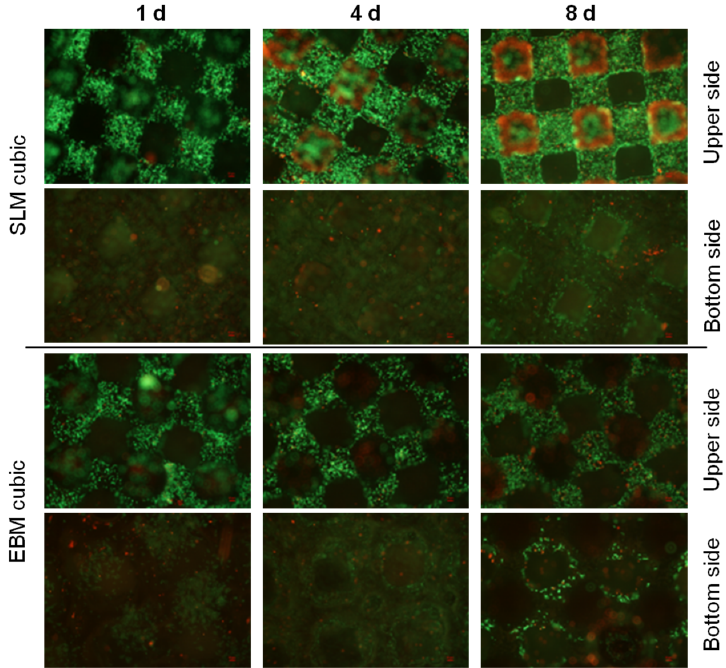
Figure 6. Live/dead staining of cubic scaffolds after static cultivation (one day, four days and eight days). Living cells are displayed in green, dead ones in red. Magnification: 40×. Scale bar: 50 µm (down right).